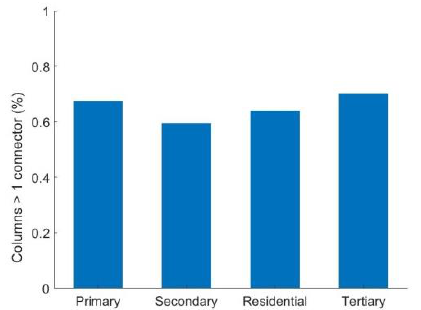
Figure 8. Percentage of charging columns with more than one connector by road segment.